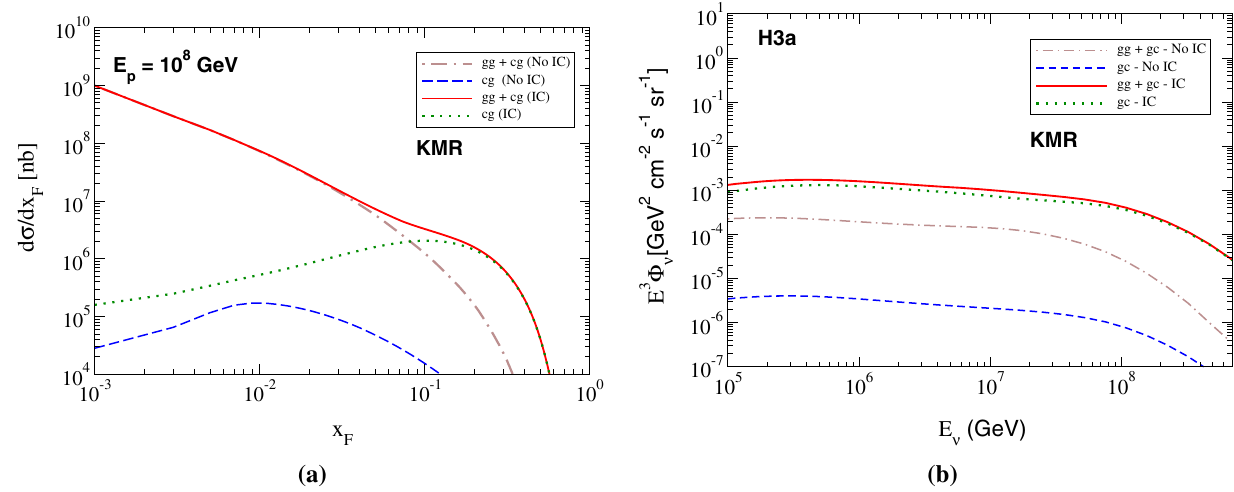
Fig. 6 Predictions of the hybrid model for a the Feynman x F - distributionsforcharmparticlesand b thepromptneutrinoflux(rescaled by E 3 ν ), calculated using the KMR model for the uPDF. The predictions